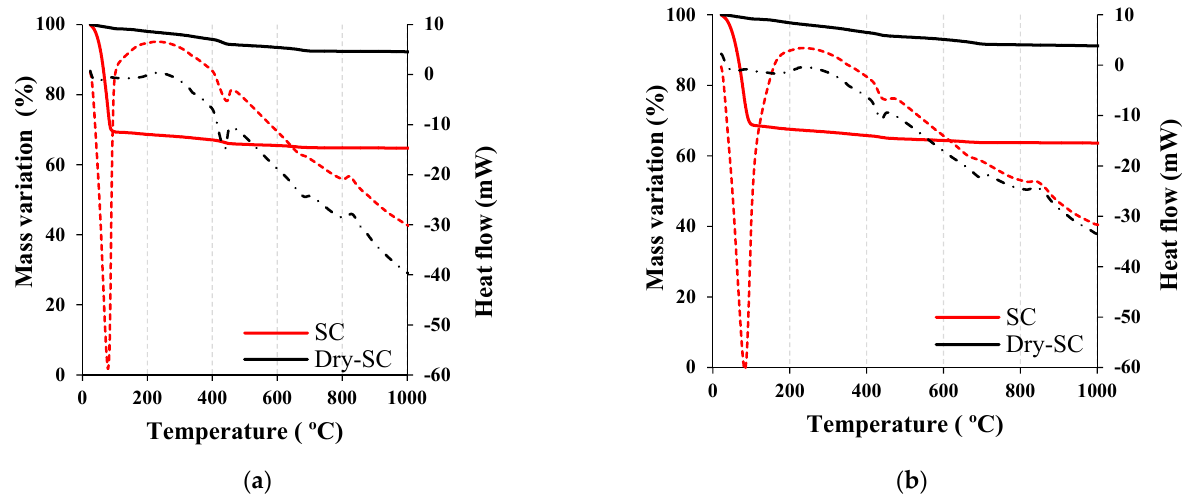
Figure 12. Thermal analysis of ( a ) NP1 − lime mixture and ( b ) NP2 − lime mixture.